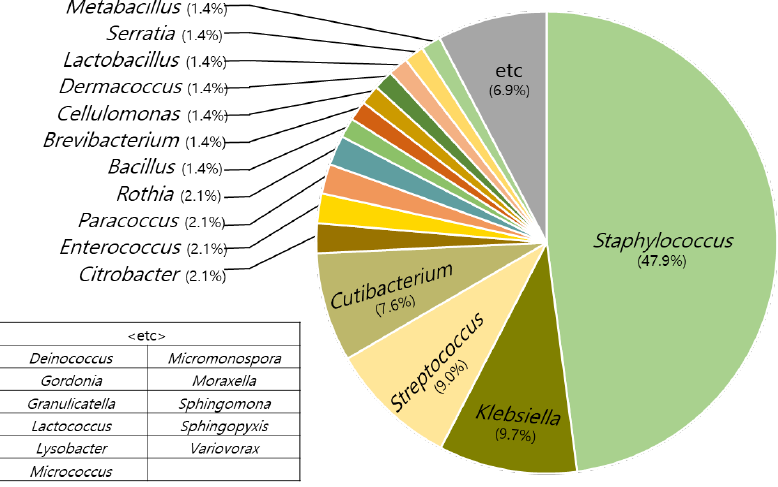
Figure 1. Genus types and distributions of isolated microbiomes.